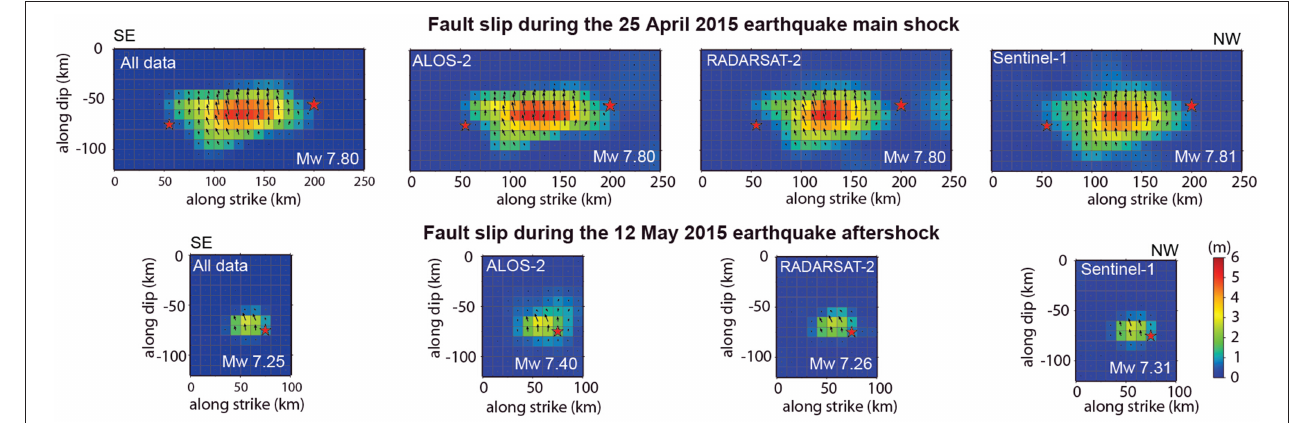
( Figure 5 ). Computing the CFS change following an earthquake tells whether a fault has been brought closer or away from rupture (Stein, 1999) and has been applied specifically to the Himalayas (Bollinger et al., 2004).Our models are loaded by the earthquake mainshock, and the receiving plane is subparallel to this mainshock plane. The CFS has significantly decreased in the main rupture area of the mainshock, as expected. In contrast, the CFS was highly increased in area surrounding the main rupture, especially at the down-dip and up-dip area of the main rupture ( Figure 5 ). One of the largest stress build up regions is found at the eastern area down-dip of the main rupture, which coincides with the location of the largest